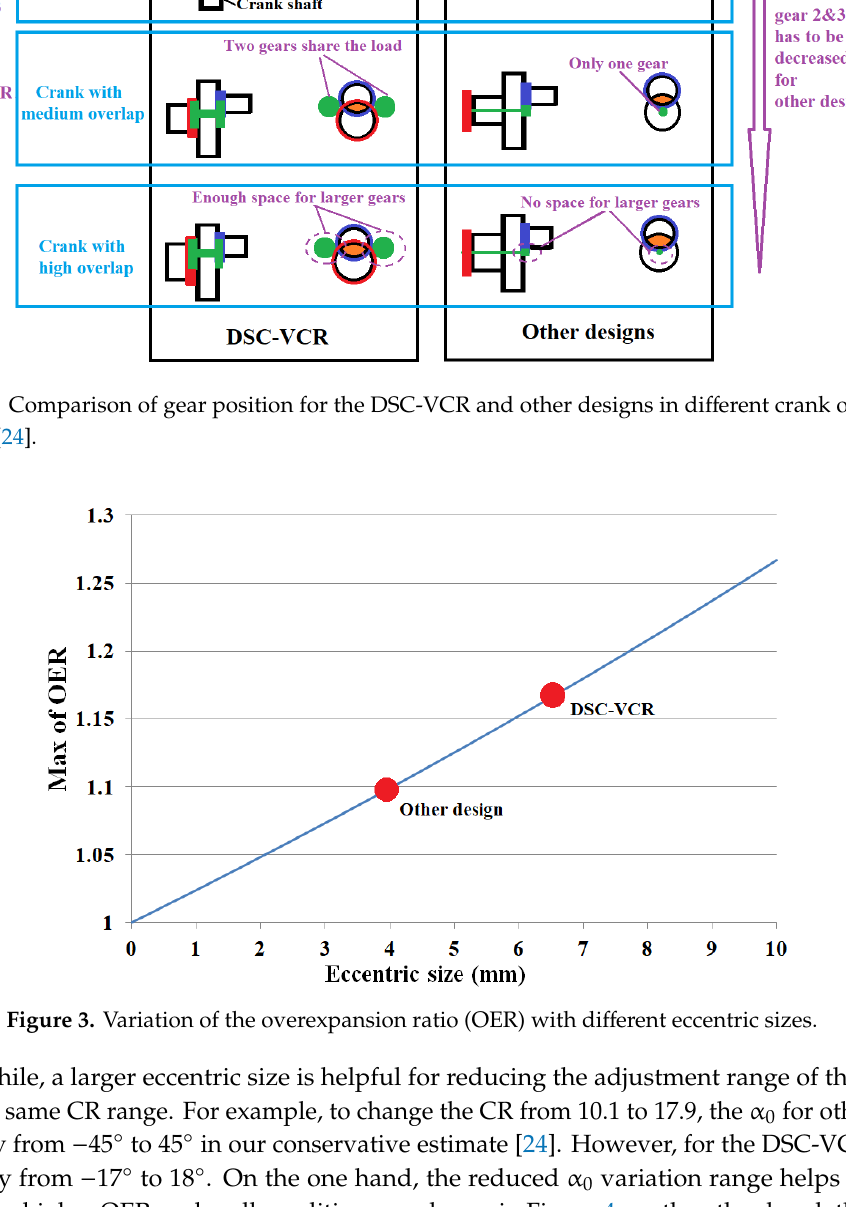
Figure 3. Variation of the overexpansion ratio (OER) with different eccentric sizes.